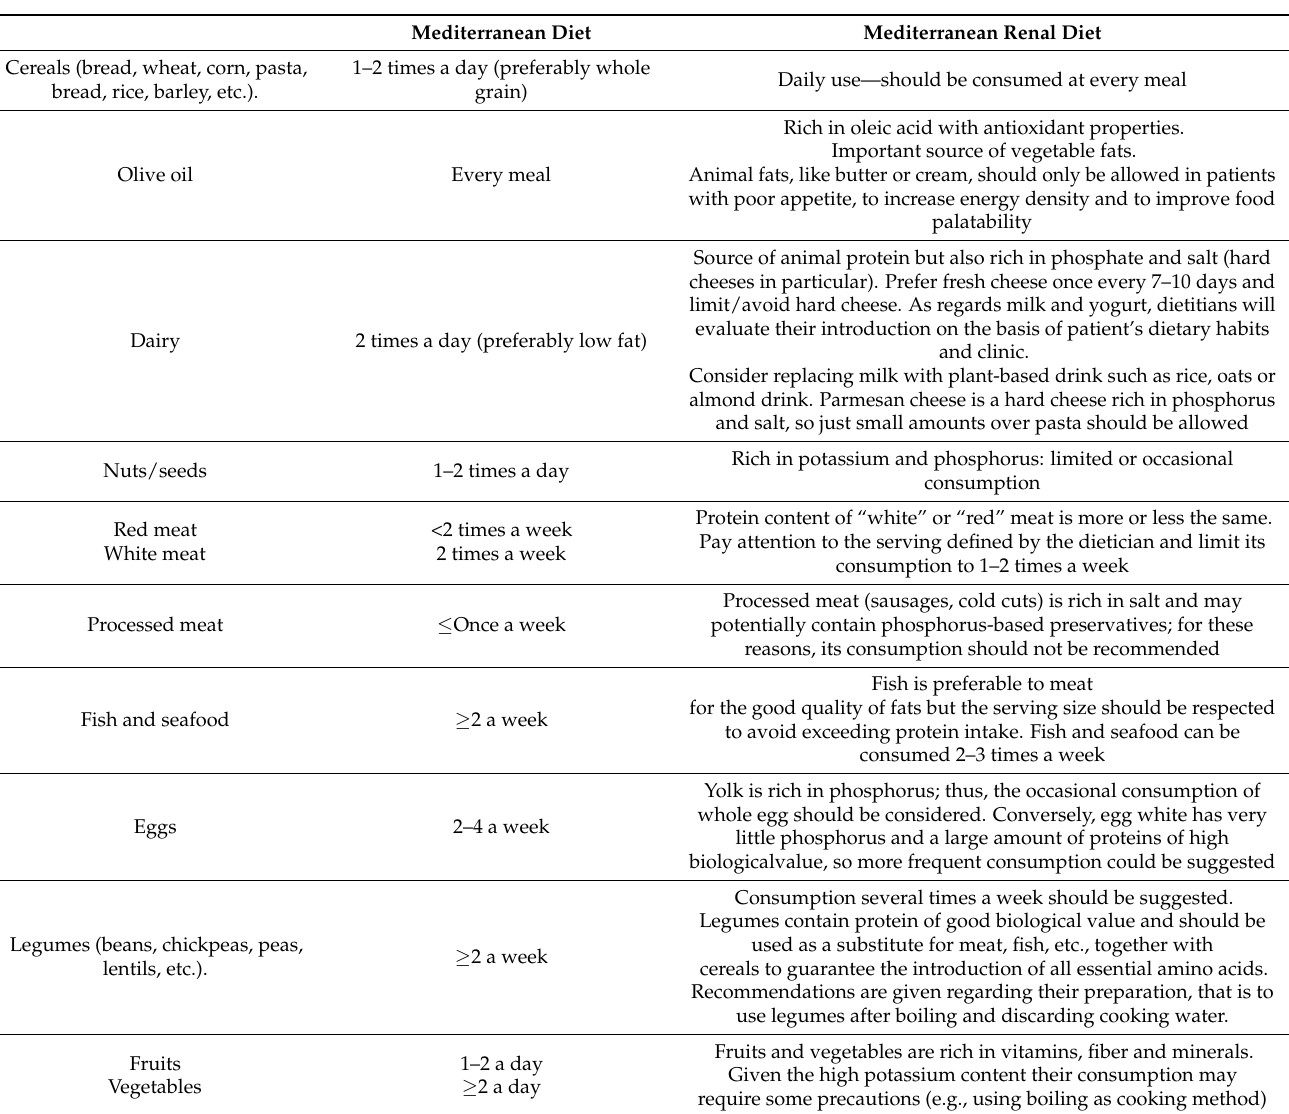
Table 1. Main characteristics of the Mediterranean diet (2nd column) and the Mediterranean Renal diet (3rd column). The third column listed changes to adapt Med diet to CKD patients’ needs. Mediterranean